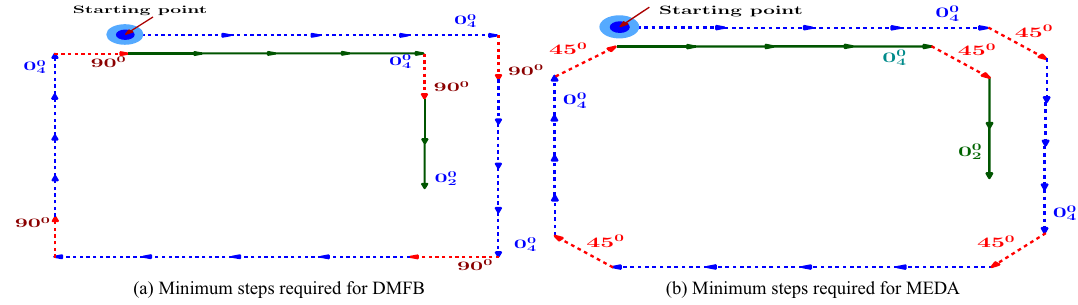
Fig. 11 Minimum steps required for mixing completion by RBS